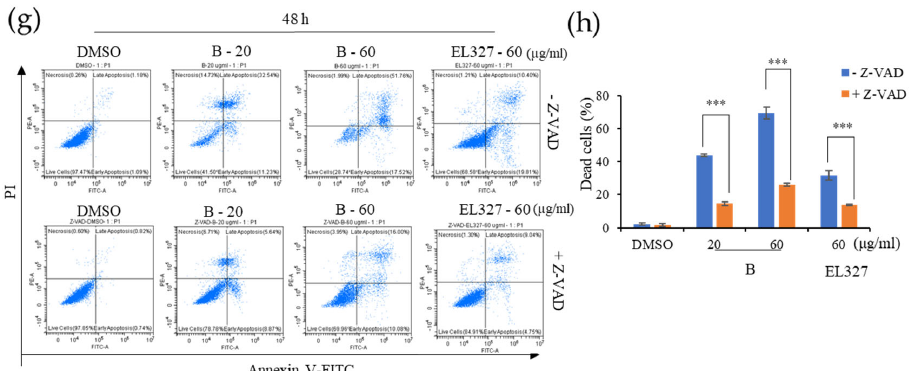
Figure 3. B induces caspase dependent apoptosis in Caco2 cells. ( a ) Nuclei condensation of Caco2 cells upon treatment with B (20, 60 µ g/mL) or EL000327 (60 µ g/mL) for 12 h, as determined by Hoechst staining. Arrowheads indicate nuclear condensation in cells. ( b ) Quantification of condensed nuclei in Caco2 cells treated with indicated concentrations of B or EL000327. ( c ) Caspase 3/7 (green) staining of Caco2 cells treated with B (20, 60 µ g/mL) or EL000327 (60 µ g/mL) for 48 h. ( d ) Quantification of apoptotic cells stained with Caspase 3/7 after treatment with the indicated concentrations of B or EL000327. ( e ) Annexin V staining of Caco2 cells treated with B (20, 60 µ g/mL) or EL000327 (60 µ g/mL) for 48 h in the presence or absence of the caspase inhibitor Z-VAD-FMK (10 µ M). ( f ) Quantification of apoptotic cells stained with Annexin V after treatment with the indicated concentrations of B or EL000327 in the presence or absence of Z-VAD-FMK (10 µ M). ( g ) Flow cytometric analysis of dead cells stained by Annexin v-FITC (apoptotic cells) and PI (necrotic cells) upon the treatment of B (20, 60 µ g/mL) or EL000327 (60 µ g/mL) for 48 h in the presence or absence of Z-VAD-FMK (10 µ M). ( h ) Quantification of the percentage of apoptotic cells treated with indicated concentrations of B and EL000327 and analyzed by flow cytometry in the presence or absence of Z-VAD-FMK (10 µ M). Results are representative of three independent experiments. Data represent the mean ± S.D. ** p < 0.01, *** p < 0.001; compared with the DMSO-treated control or Z-VAD-FMK treated